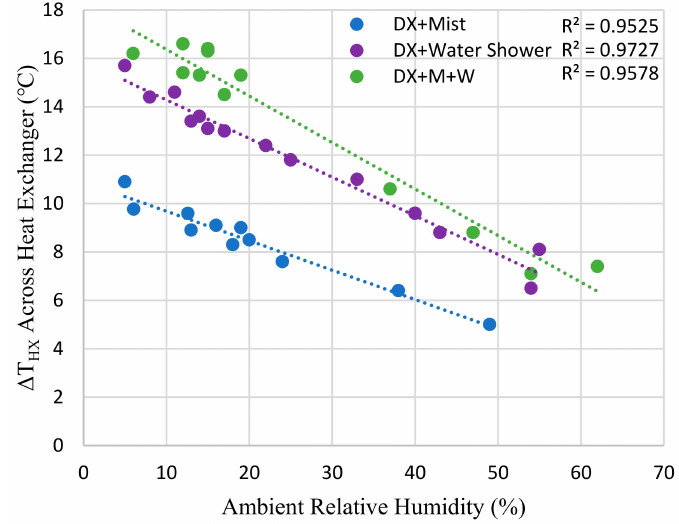
Figure 10. Variation with a relative humidity of ∆ T HX across heat exchanger for ambient temperatures higher than 40 ◦